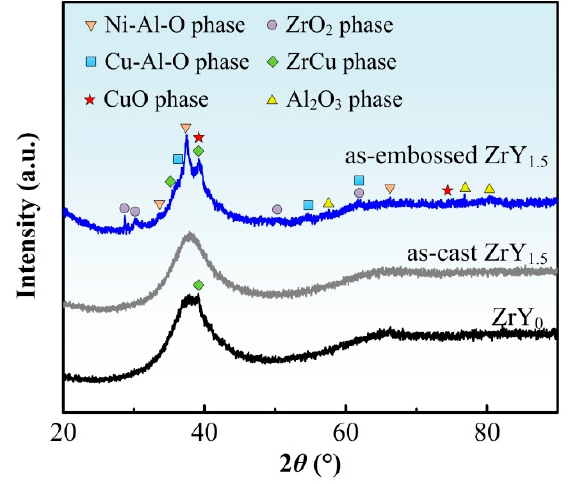
Figure 2. XRD patterns of the two as-cast BMGs and the as-embossed ZrY 1.5 surface.